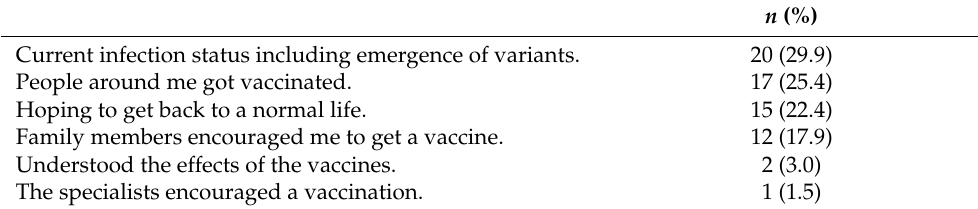
Table 9. Reasons for changes in vaccination attitude ( n =